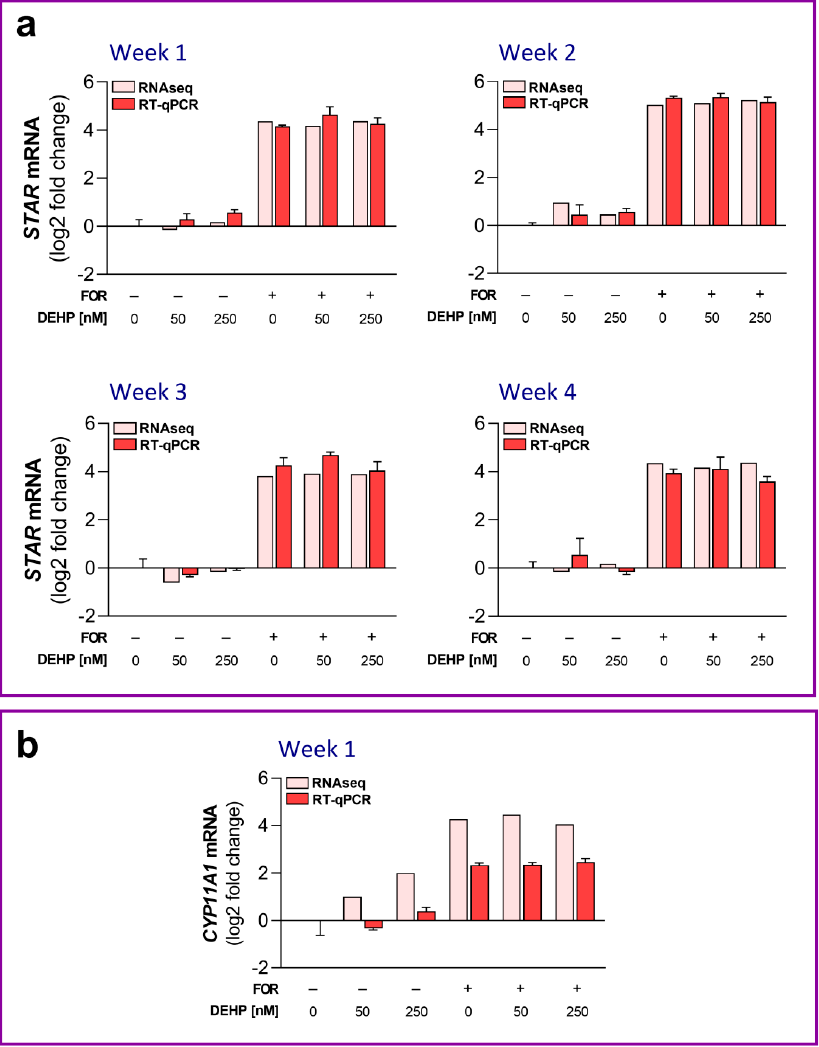
Figure 7. Validation study of the RNAseq data by RT-qPCR. ( a ) The STAR mRNA expression levels in HGrC1 cells were analyzed by RT-qPCR after 1, 2, 3, and 4 weeks of the repeated DEHP50 and DEHP250 exposure under the basal and FOR-stimulated conditions and were compared to the RNAseq data. ( b ) The CYP11A1 mRNA expression levels in HGrC1 cells were analyzed by RT-qPCR after 1 week of the repeated DEHP50 and DEHP250 exposure under the basal and FOR-stimulated conditions and were compared to the RNAseq data. The results are expressed relative to the control that was set as 0 in each week of exposure. In the RT-qPCR experiments, each data point represents the mean ± SEM of three independent experiments.